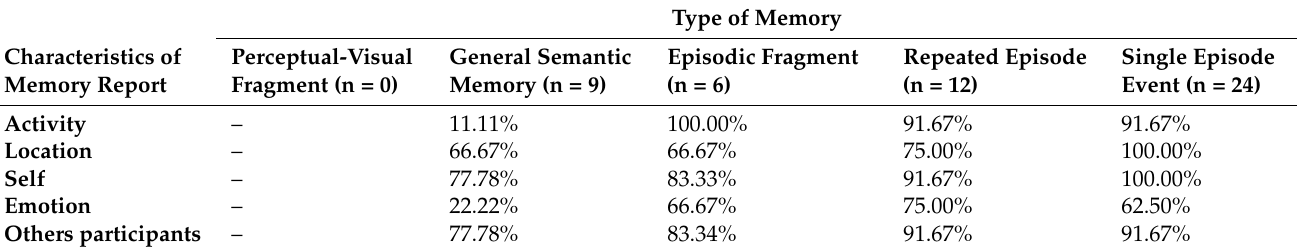
Table 4. Frequencies of the details reported according to the different types of memories when present in epoch 1 (the different types of memory reported are